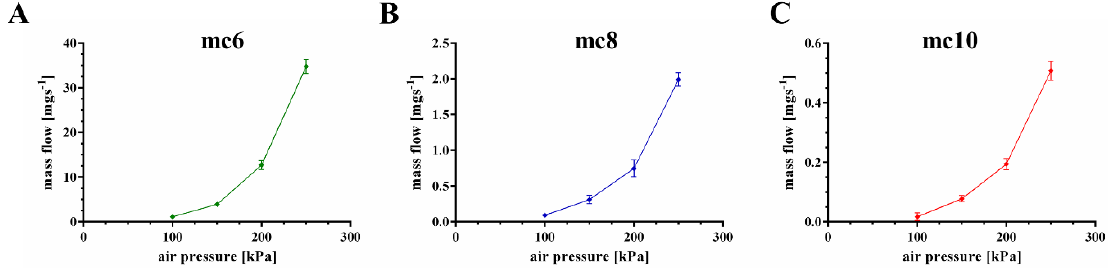
Figure 3. Mass flow of mc6, mc8, and mc10 pastes through a cylindrical needle (inner diameter 250 μm); consider the changes of the y -axes (mean ± SD, n = 3).